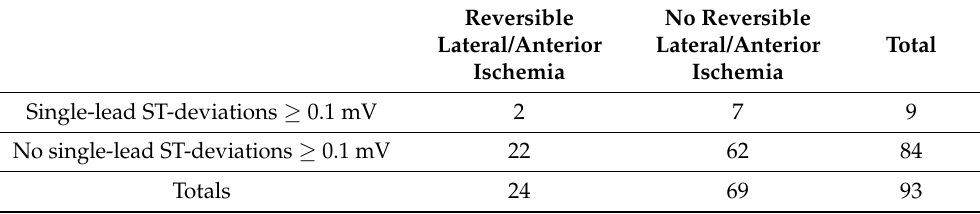
Table 3. 2 × 2 table showing the number of patients with significant ST deviations ≥ 0.1 mV on the single-lead ECG and how they relate to the results from the cardiac-PET divided into reversible anterolateral ischemia or no reversible anterolateral